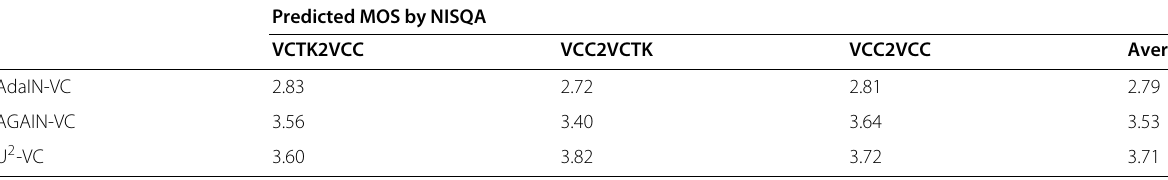
Table 12 Objective evaluation results of voice conversion in cross-lingual scenario